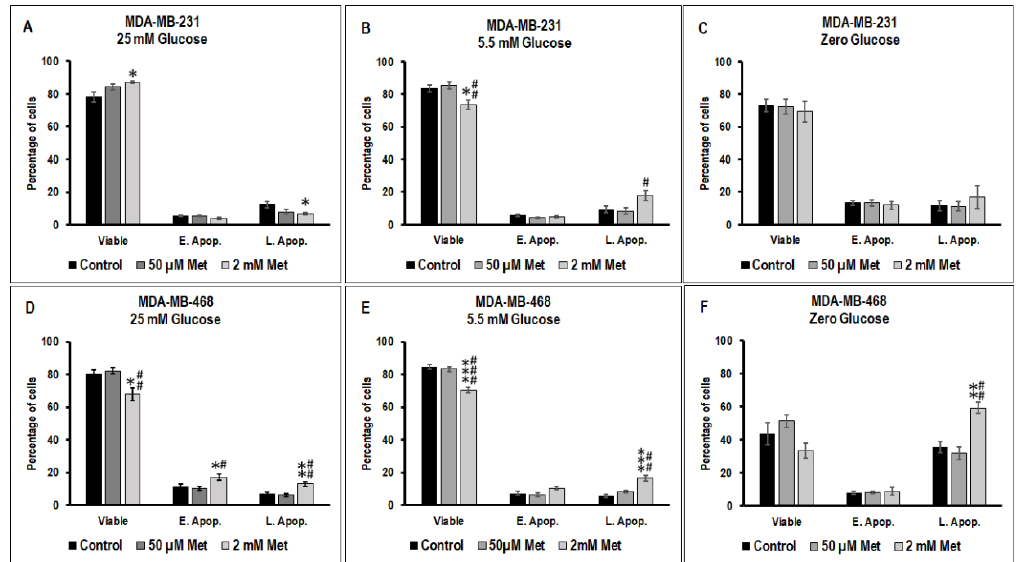
Figure 2. The effect of metformin (50 µ M and 2 mM) on apoptosis in 25 mM, 5.5 mM, and zero glucose/glucose-starved conditions in MDA-MB-231 and MDA-MB-468 cells was measured using flow cytometry with fluorescein isothiocyanate (FITC) tagged Annexin V and propidium iodide (PI) in ( A ) MDA-MB-231 cells at 25 mM glucose condition, ( B ) MDA-MB-231 cells at 5.5 mM glucose condition, ( C ) MDA-MB-231 cells at zero glucose/glucose-starved condition, ( D ) MDA-MB-468 cells at 25 mM glucose condition, ( E ) MDA-MB-468 cells at 5.5 mM glucose condition, and ( F ) MDA-MB-468 cells at zero glucose/glucose-starved condition. ‘E. Apop.’ indicates early apoptotic events and ‘L. Apop.’ indicates late apoptotic events. Data represent the mean ± standard error of mean of 5–7 independent experiments. p -value < 0.05, ** p -value < 0.01, and *** p -value < 0.001 was considered to be significant with respect to untreated control and # p -value < 0.05, ## p -value < 0.01, and ### p -value < 0.001 was considered to be significant with respect to 50 µ M metformin treated